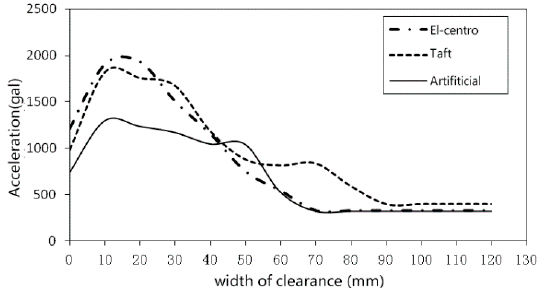
Figure 9. Maximum acceleration value changes with clearance width in model A.